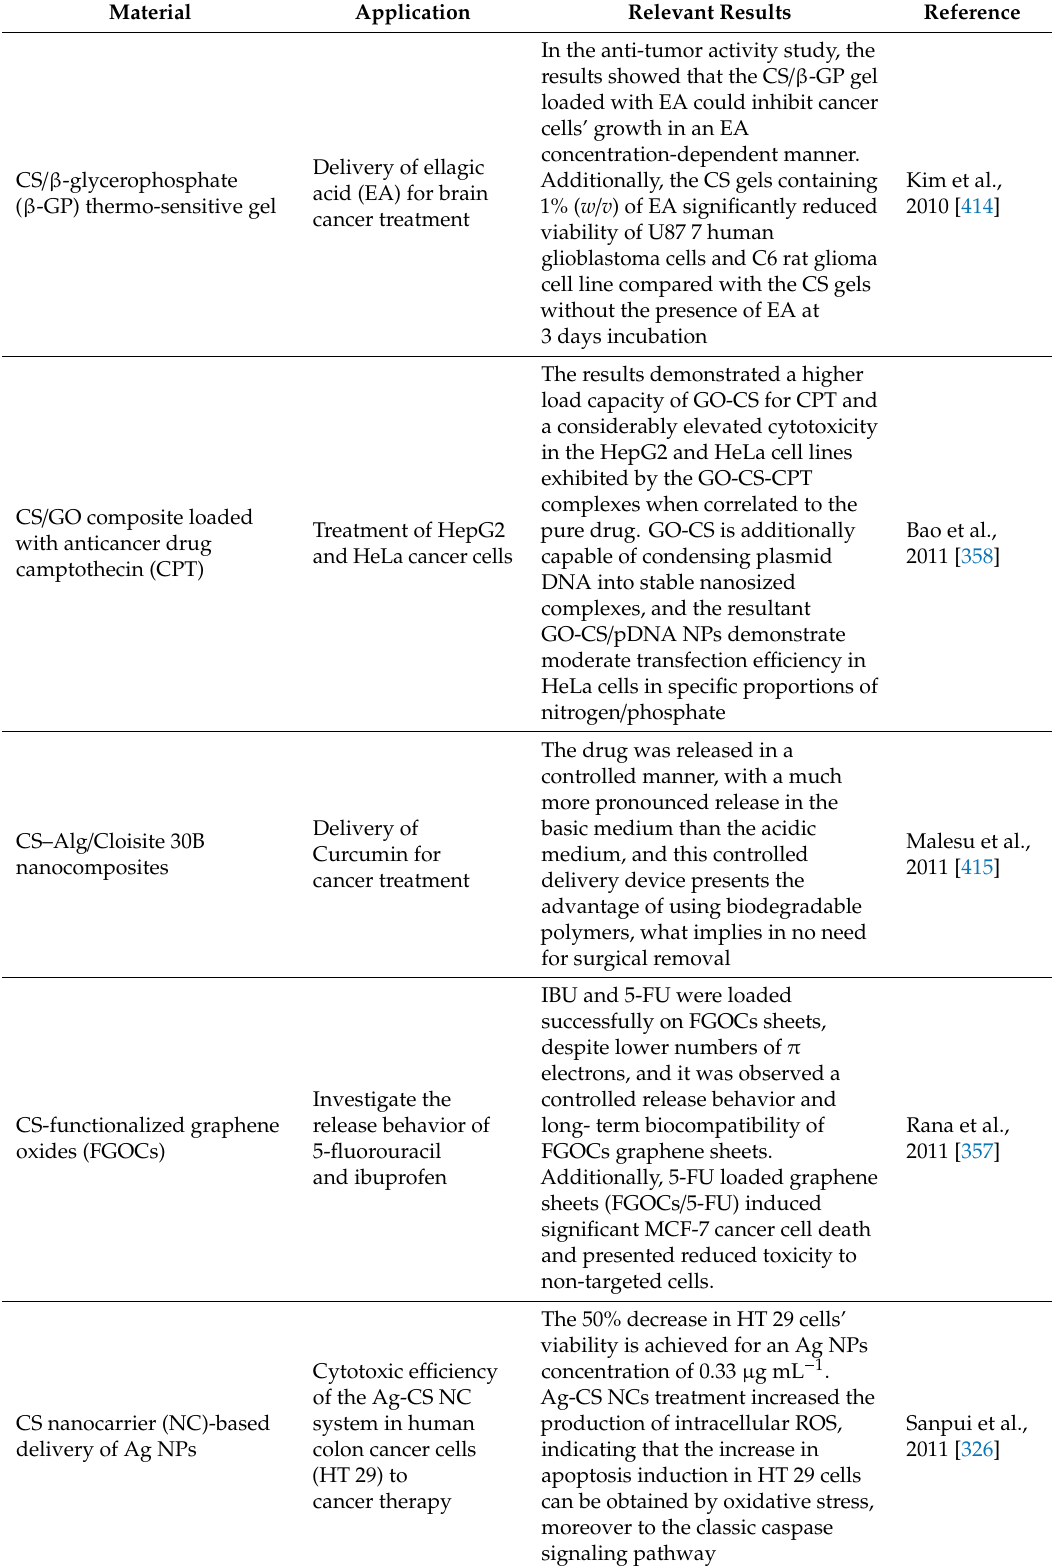
Table 3. Studies of chitosan (CS) and chitosan-based systems’ uses in cancer treatment over the last 10